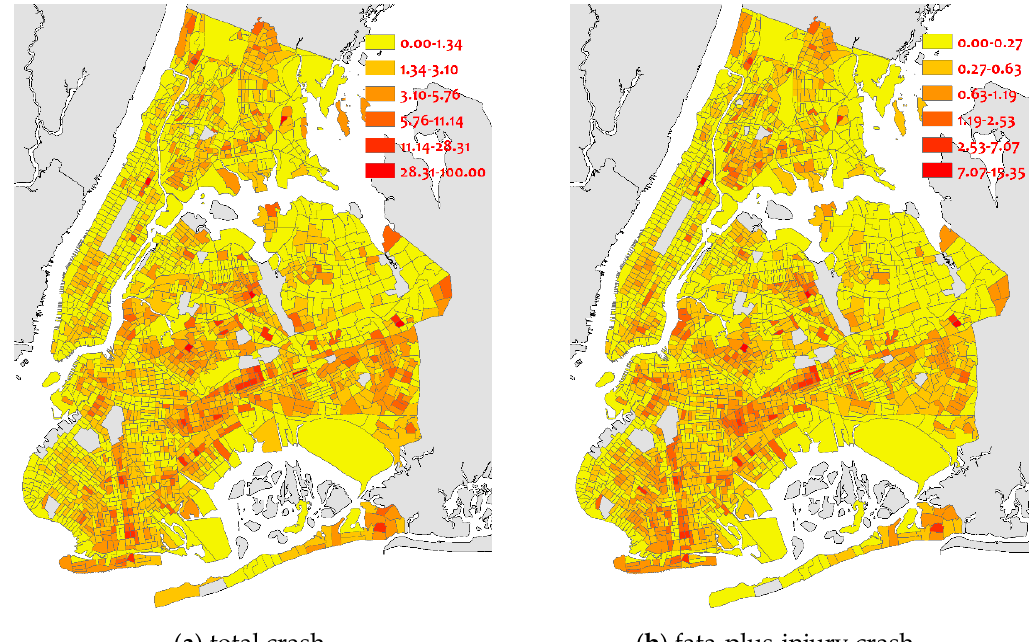
Figure 2. Spatial distribution of crash rates.